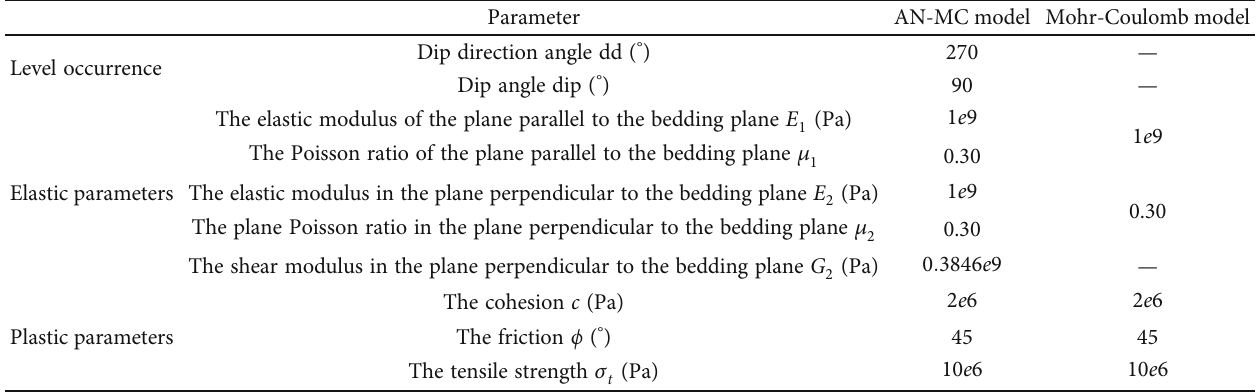
Table 3: Calculation parameters of constitutive model